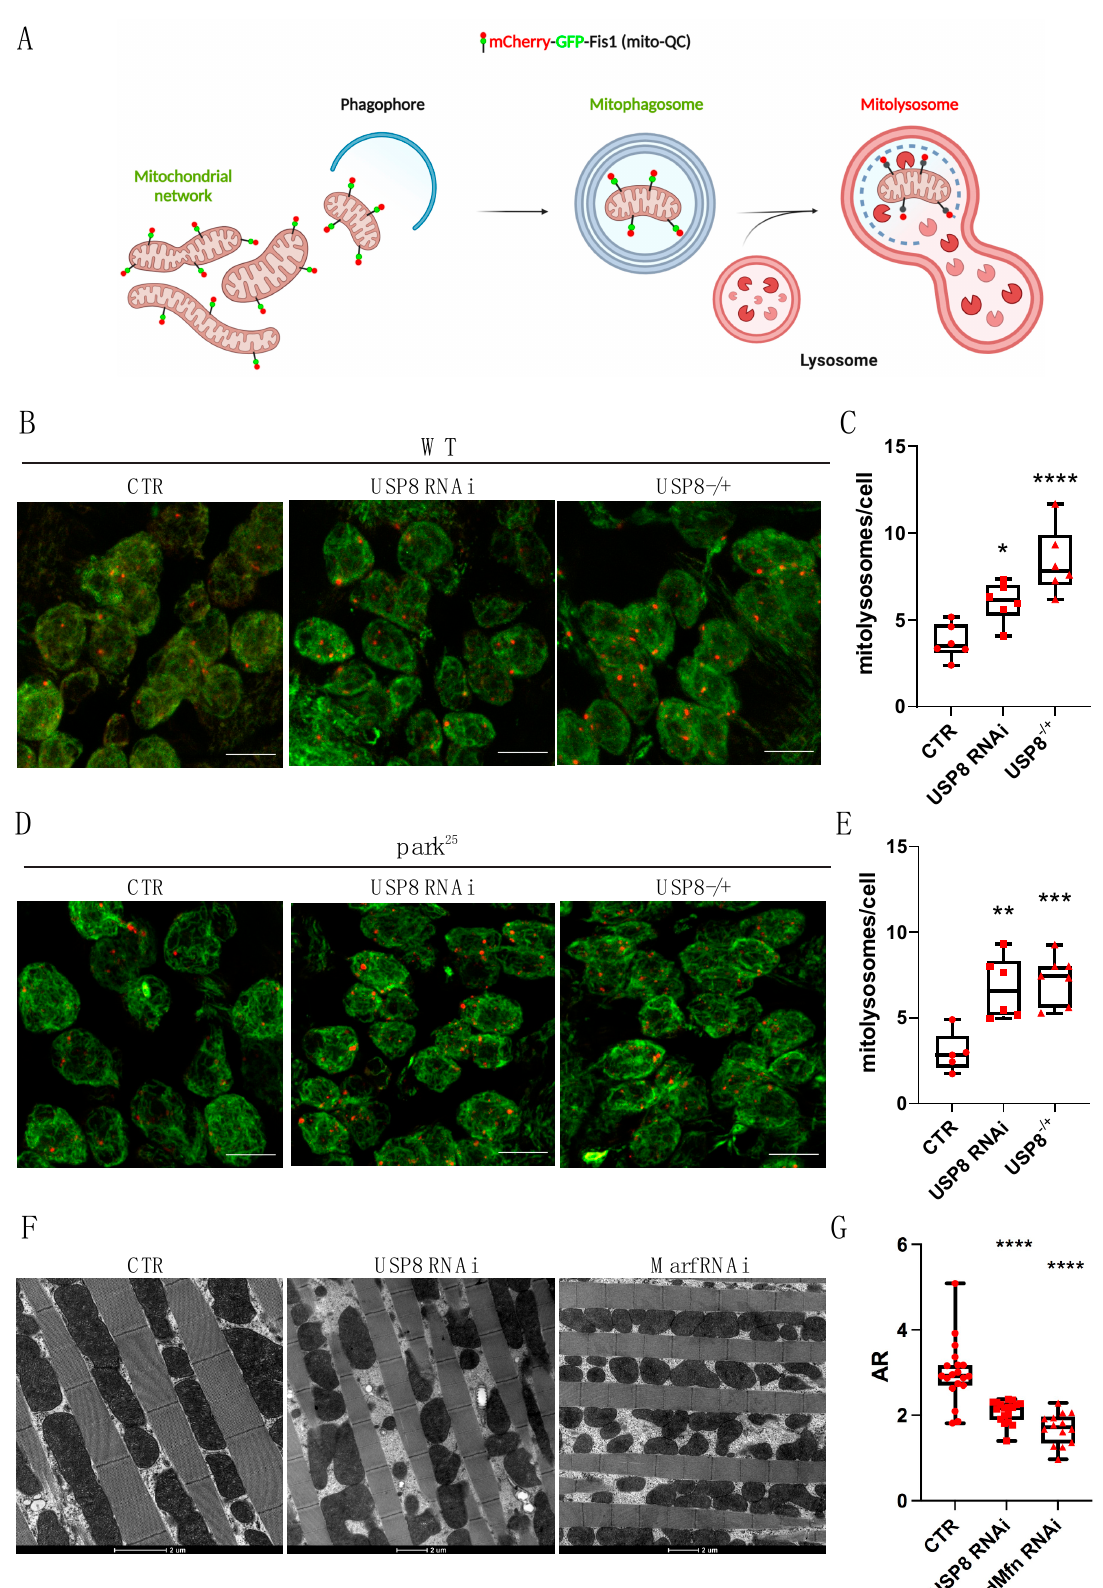
Figure 2. ( A ) Graphical representation of the mito-QC construct. A tandem mCherry–GFP tag is targeted to the OMM. Under normal conditions, mitochondria display both mCherry and GFP fl uorescence. The GFP signal is quenched upon mitochondria fusion to lysosomes. In the acidic environment of the lysosomes the number of mCherry-only foci (red dots) allows quanti fi cation of